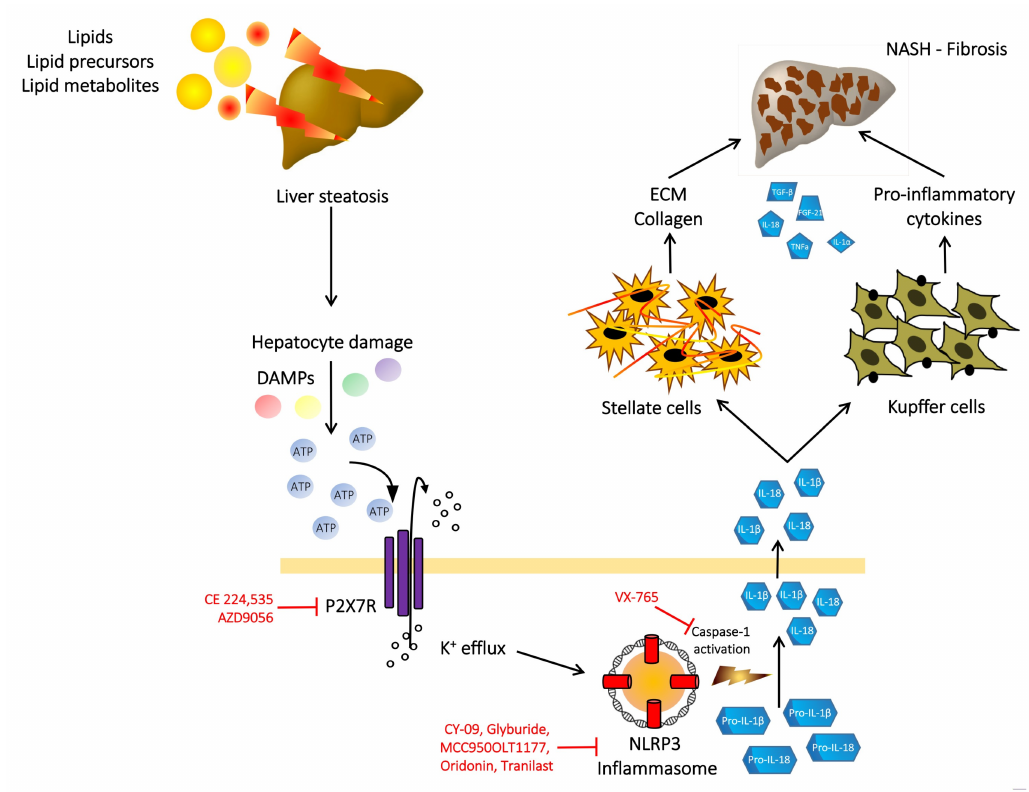
Figure 1. Schematic illustration of the P2X7 receptor / NLRP3 inflammasome axis involvement in non-alcoholic fatty liver disease (NAFLD) pathogenesis and evolution to non-alcoholic steatohepatitis (NASH) and liver fibrosis. Upon exposure to an injury (for example due to lipid accumulation), damaged or dead hepatocytes release molecules (such as adenosine tri-phosphate - ATP) acting as danger-associated molecular patterns (DAMPs) on the P2X7R receptor which activation determines the assembly and activation of the NLRP3 inflammasome and the following cascade leading to caspase-1 activation, pro-IL 1 β and pro-IL 18 cleavage and mature IL-1 β and Il-18 release. These inflammatory cytokines modulate the activity of the stellate and Kup ff er cells, further amplifying the inflammatory process, determining NASH and liver fibrosis due to extracellular matrix and collagen deposition. In red are reported the possible therapeutical targets to inhibit the inflammatory response due to P2X7 receptor / NLRP3 inflammasome axis